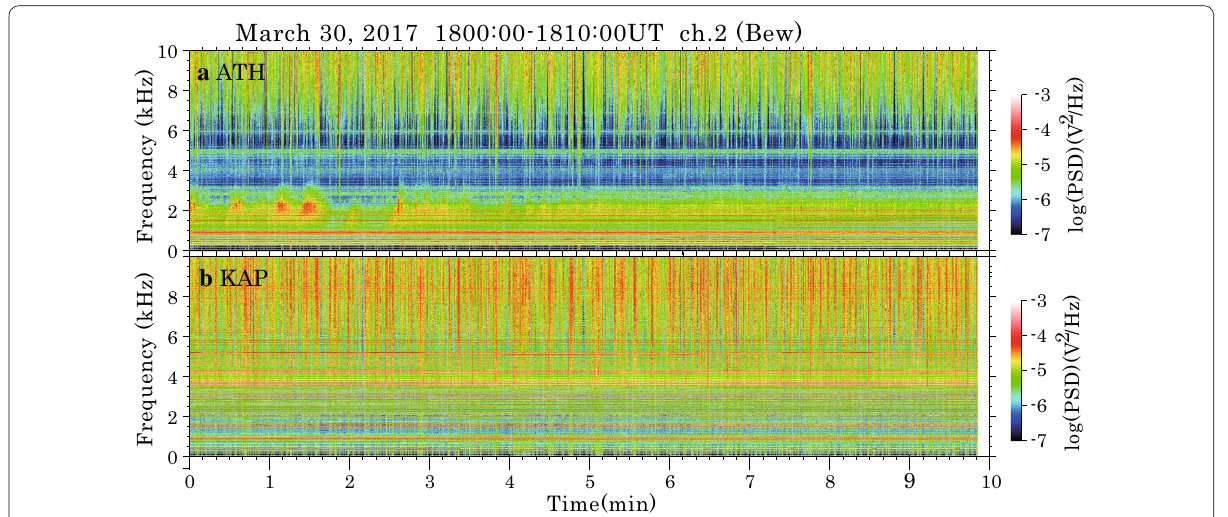
Fig. 15 Ten‑minute spectra of ELF/VLF waves observed by loop antennas at ATH, and